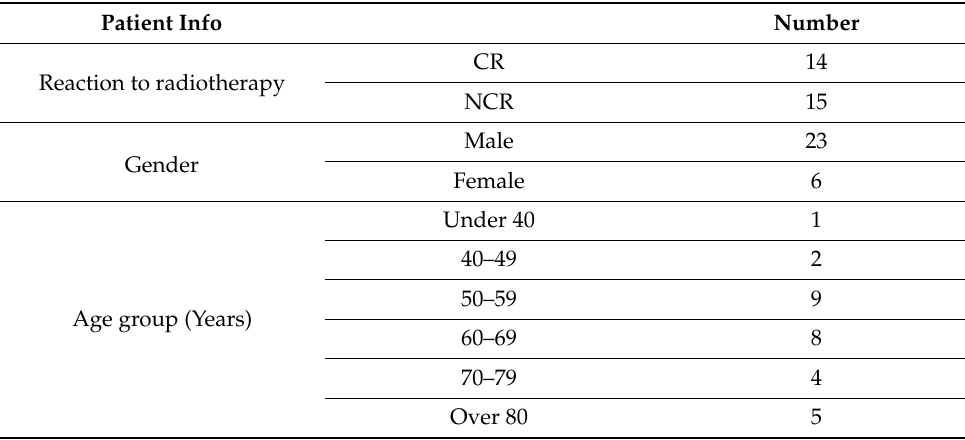
Table 1. Demography of patients with rectal cancer selected for whole exome